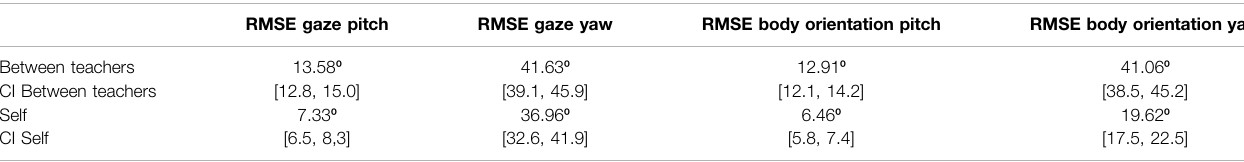
TABLE 1 | RMSE (in degrees) for gaze and body orientation pitch and yaw angles, based on the estimations provided by the four teachers, and the respective 95% Con fi dence